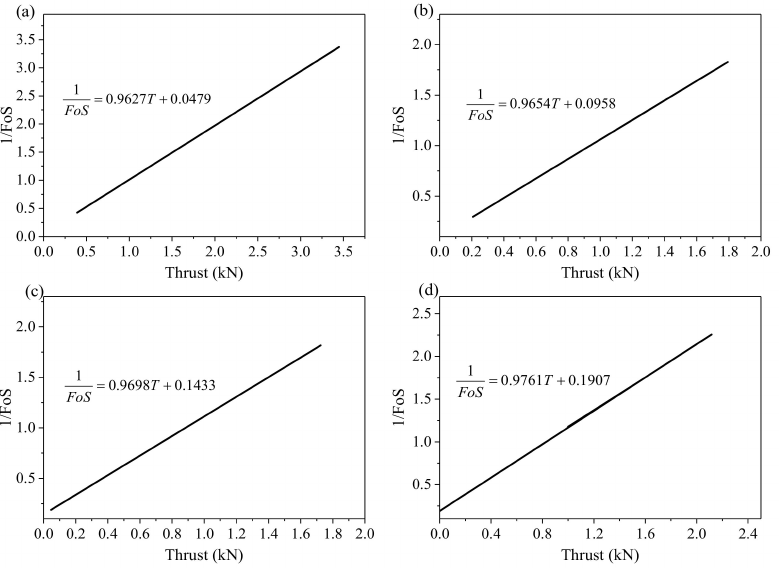
Figure 6. Reciprocal of the factor of safety (FoS) is proportional to the thrust. ( a – d ) show the proportional relationship between reciprocal of FoS and thrust for the four